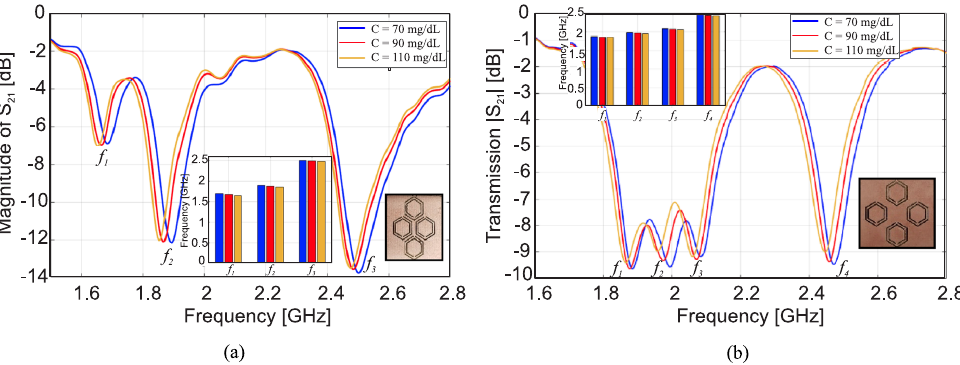
Figure 12. Measured transmission response S 21 as function of frequency for the tested glucose sam- ples of various concentrations for ( a ) compact and ( b ) dispersed sensors. Reprinted with permission from Ref. [34].